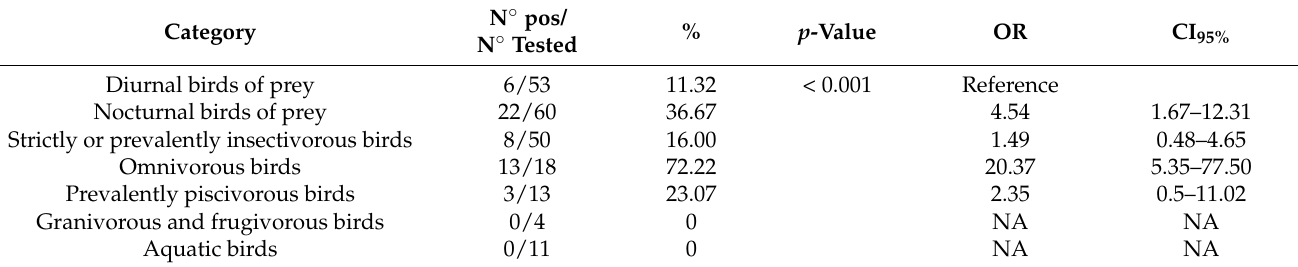
Table 4. Wild bird groups associated with Campylobacter spp.